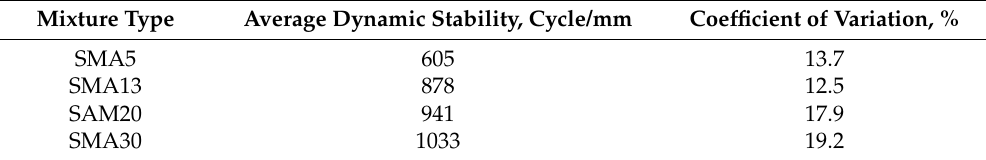
Table 7. Results of wheel tracking